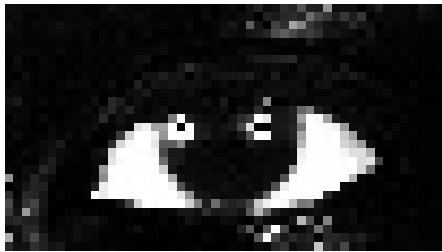
Figure 8. Sclera probability image (bright zones indicate a high sclera probability, while darker regions indicate a low sclera probability).